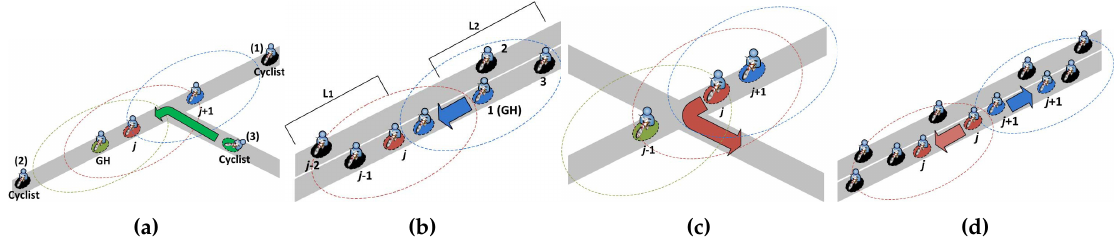
Figure 2. ( a ) A new fleet cyclist joins an existing group L ; ( b ) groups L 1 and L 2 are merged; ( c ) group cyclist j changes its direction and thus group L is split; and ( d ) group cyclist j speeds up and/or group cyclist j + 1 slows down, thus group L is